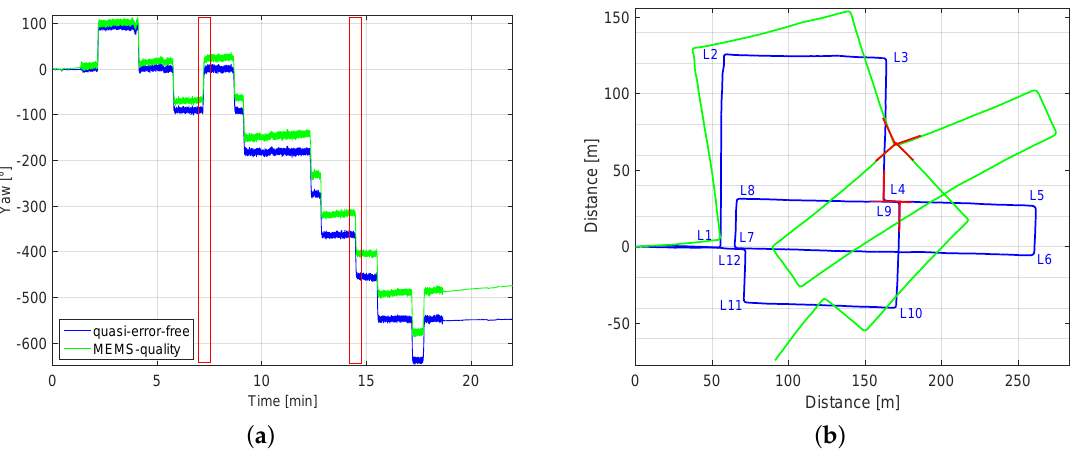
Figure 9. ( a ) represents the yaw angle estimation and ( b ) the trajectory of the walk corresponding to this experiment. The blue curves have been computed using the quasi-error-free turn rate measurements and the green curves have been computed with the MEMS-quality turn rate measurements. The corners are labeled.